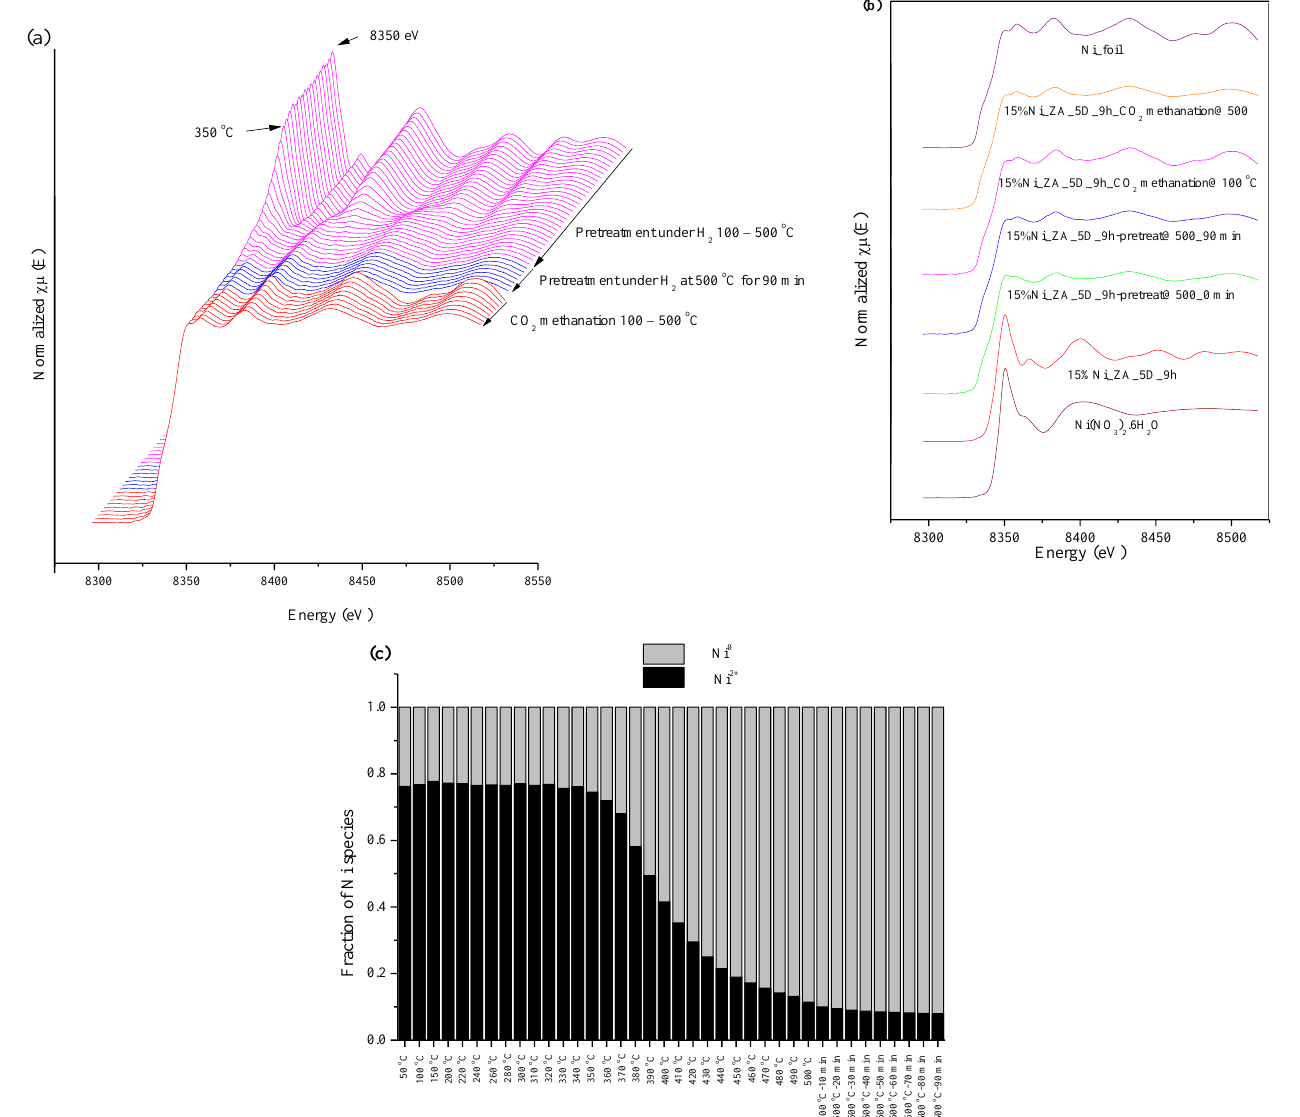
Figure 8. ( a ) Ni K-edge XANES spectra of 15wt%Ni/ZA_5D_9h during pretreatment and CO 2 methanation; ( b ) selected XANES spectra of Ni K-edge at different conditions compared with Ni°, Ni 2+ standards and fresh catalyst; and ( c ) fraction of Ni° and Ni 2+ existing on the 15wt%Ni/ZA_5D_9h catalyst during pretreatment process obtained by linear combination fitting.